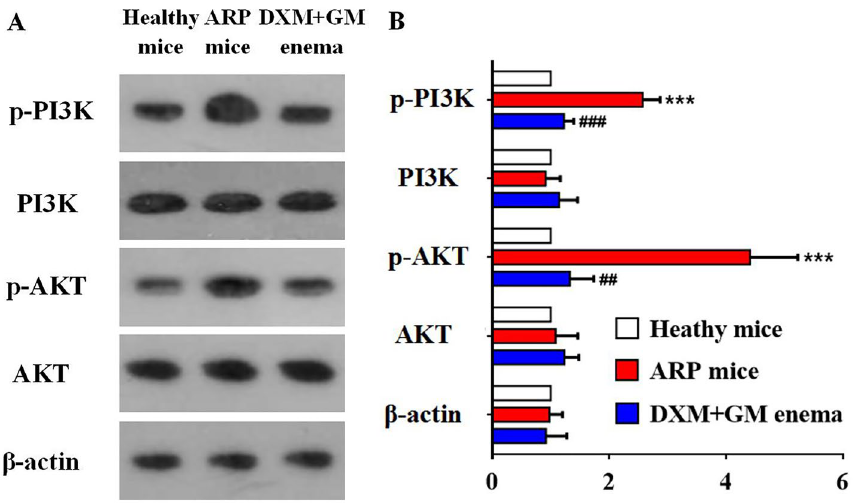
Figure 8. DXM + GM enema downregulates PI3K/AKT signaling pathway in ARP mice. ( A ) The expression of the PI3K/AKT signaling pathway was measured via western blot in rectal tissues of ARP mice treated with DXM + GM enema treatment. ( B ) The expression of p-PI3K and p-AKT in was increased in rectal tissues of ARP mice (*** P < 0.001). However, the expression levels of p-PI3K and p-AKT were significantly decreased by